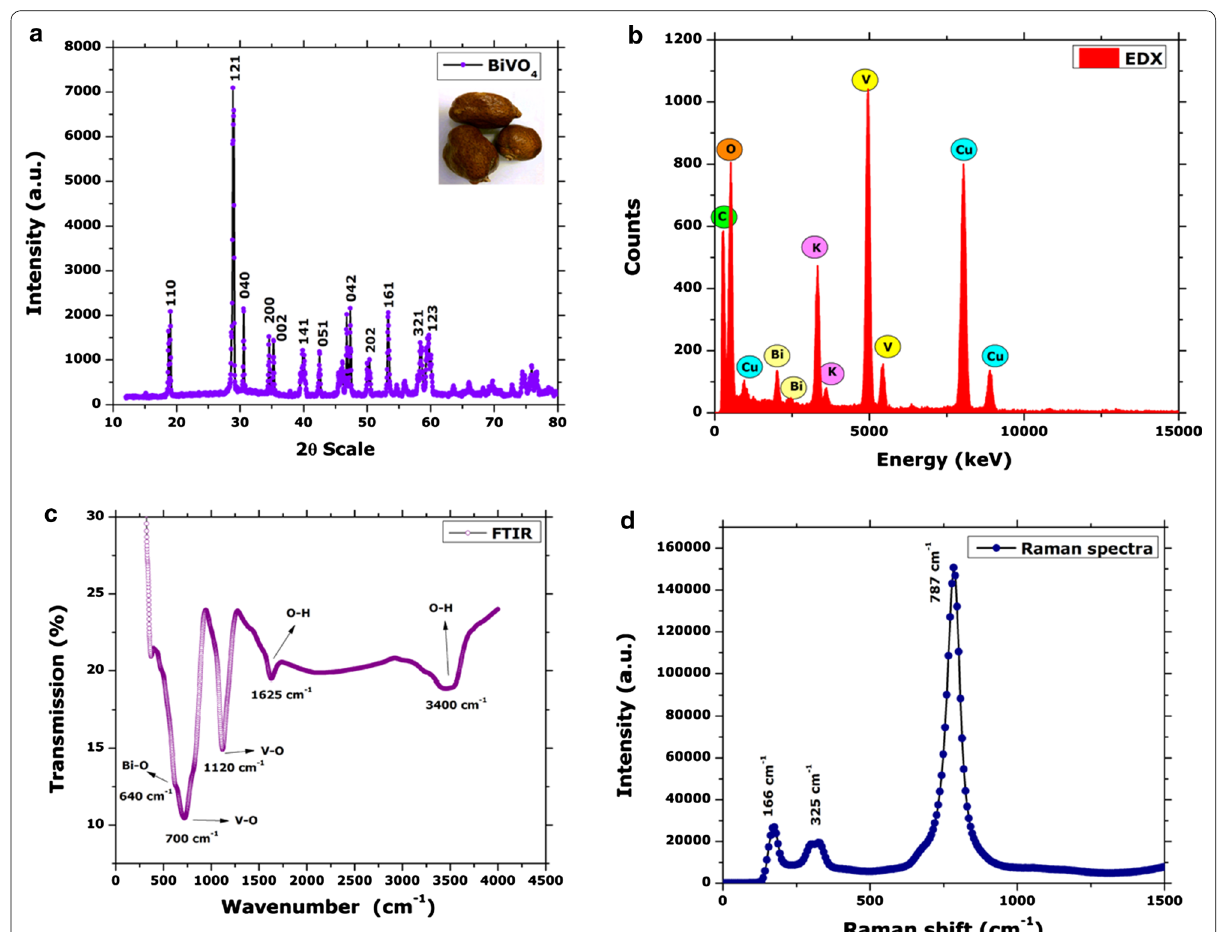
Fig. 2 Various spectroscopic characterisation performed on BiVO 4 . a X-ray diffraction pattern; b Energy Dispersive Spectra; c Fourier Transformed Infrared Spectra; d Raman